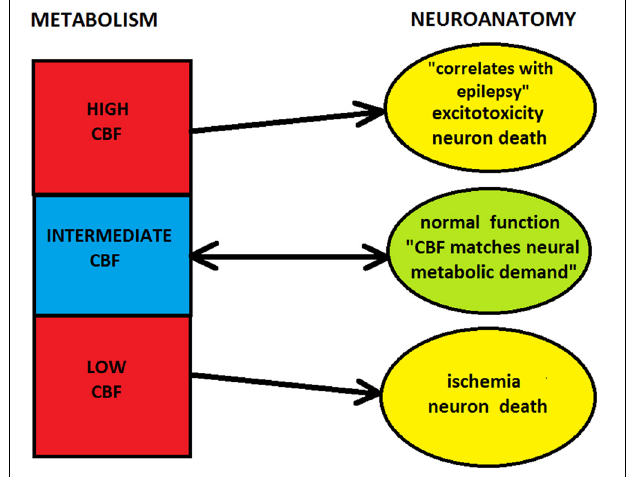
FIGURE 5 | Influence of cerebral metabolism (hemodynamics) on neuroanatomy. Too low or too high levels of CBF can lead to the damage of cortical structure. In these regimes blood flow or metabolism strongly constrain neuroanatomy, and neuro-vascular coupling is effectively one-directional, from microvasculature to neurons (i.e., neurons cannot control blood flow). However, for the intermediate level of CBF there is a “window of metabolic opportunity,” where energy supplied by blood flow meets neuronal demands. In this regime, energetic constraint on neuroanatomy is soft, and there is a two-way signaling between microvasculature and neurons (i.e., neurons can control blood